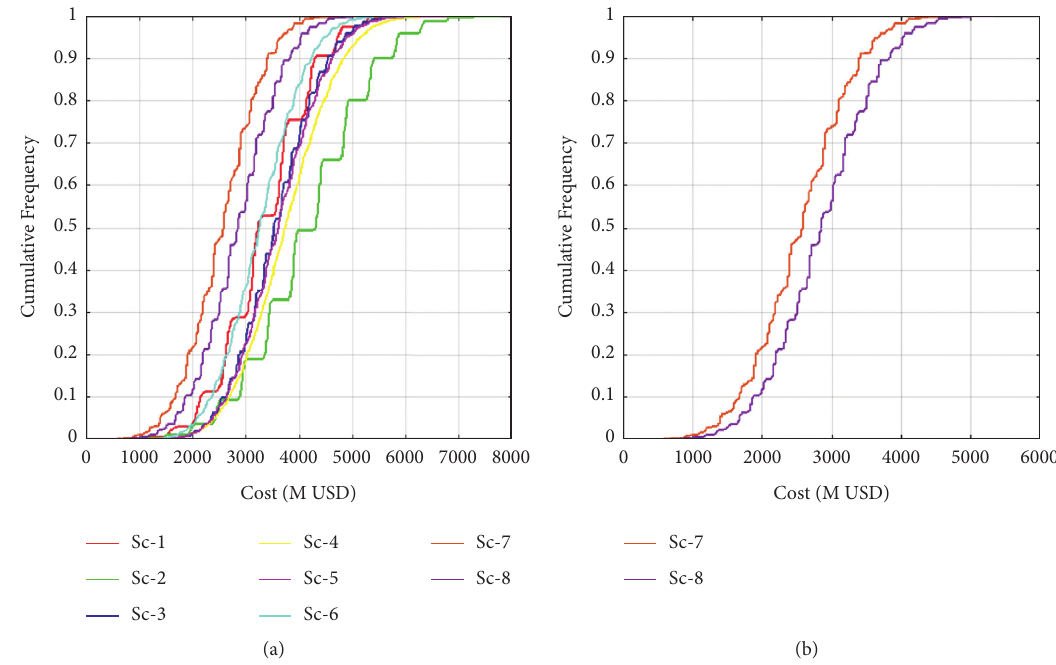
Figure 10: MATLAB simulations of cost versus cumulative frequency (a) for all scenarios and (b) for Sc-7 &